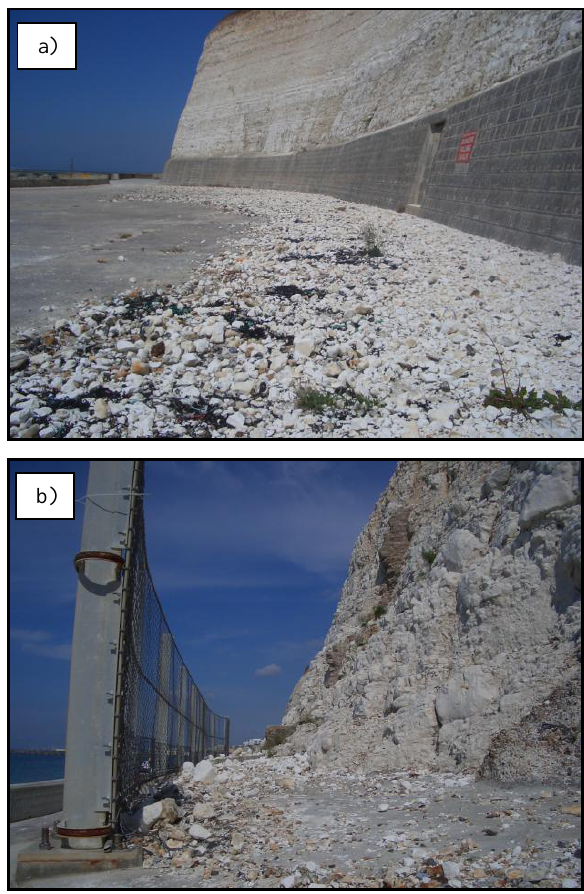
Fig. 5. ( a and b ) Examples of isolated recent chalk and flint nodules